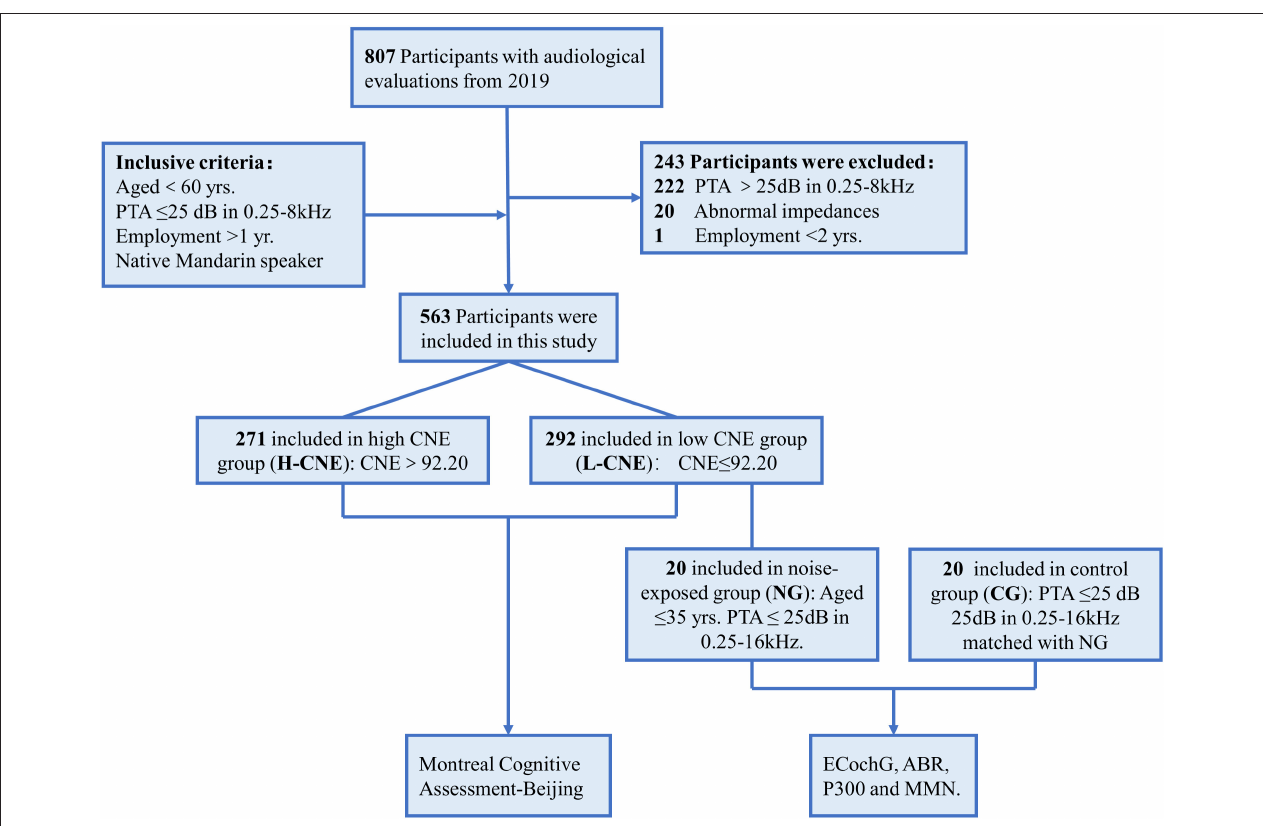
FIGURE 1 | The flowchart illustrates the study design and participants.